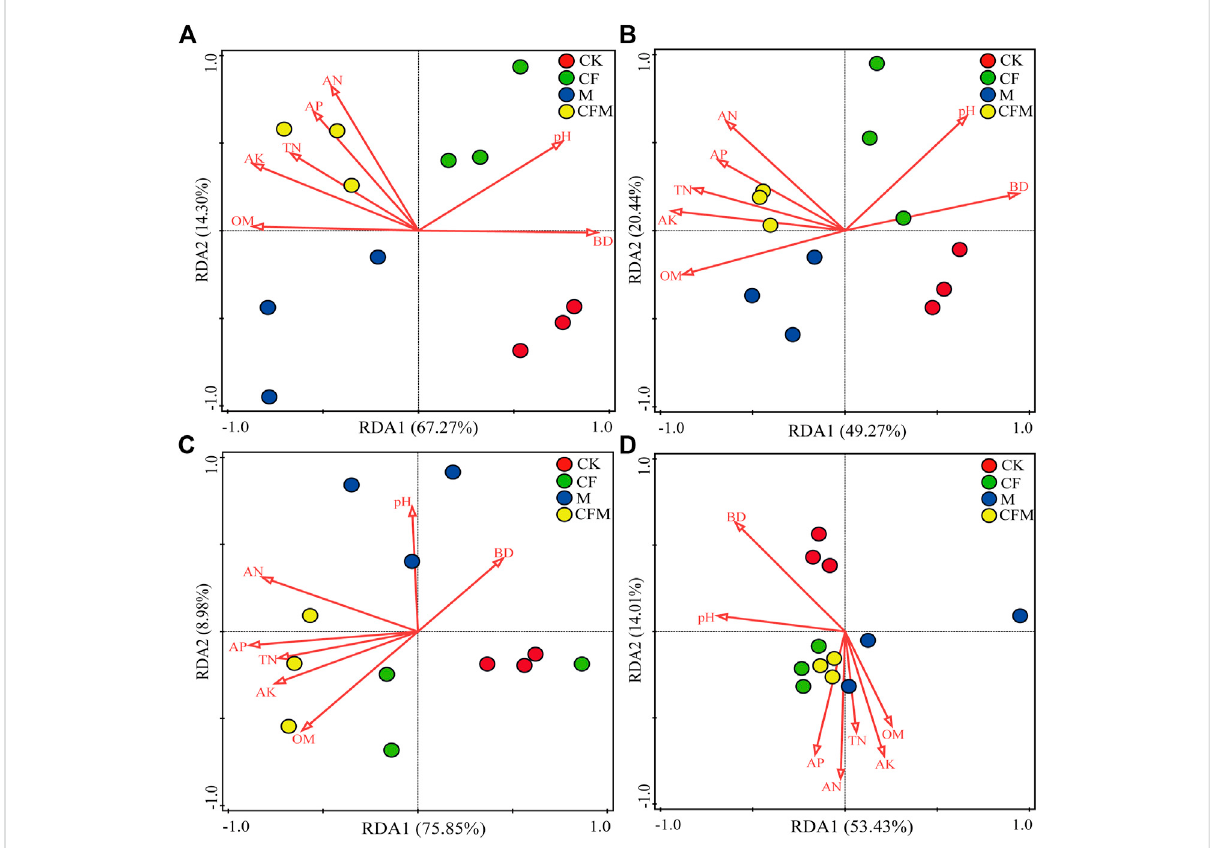
FIGURE 3 Redundancy analysis (RDA) explaining the in fl uence of soil physical and chemical parameters on the composition of soil bacterial and fungal communitiesacrossthedifferenttreatmentsafter16 years(2004 – 2019).Onlythe10mostabundantphylaand20mostabundantgenerawereused in the